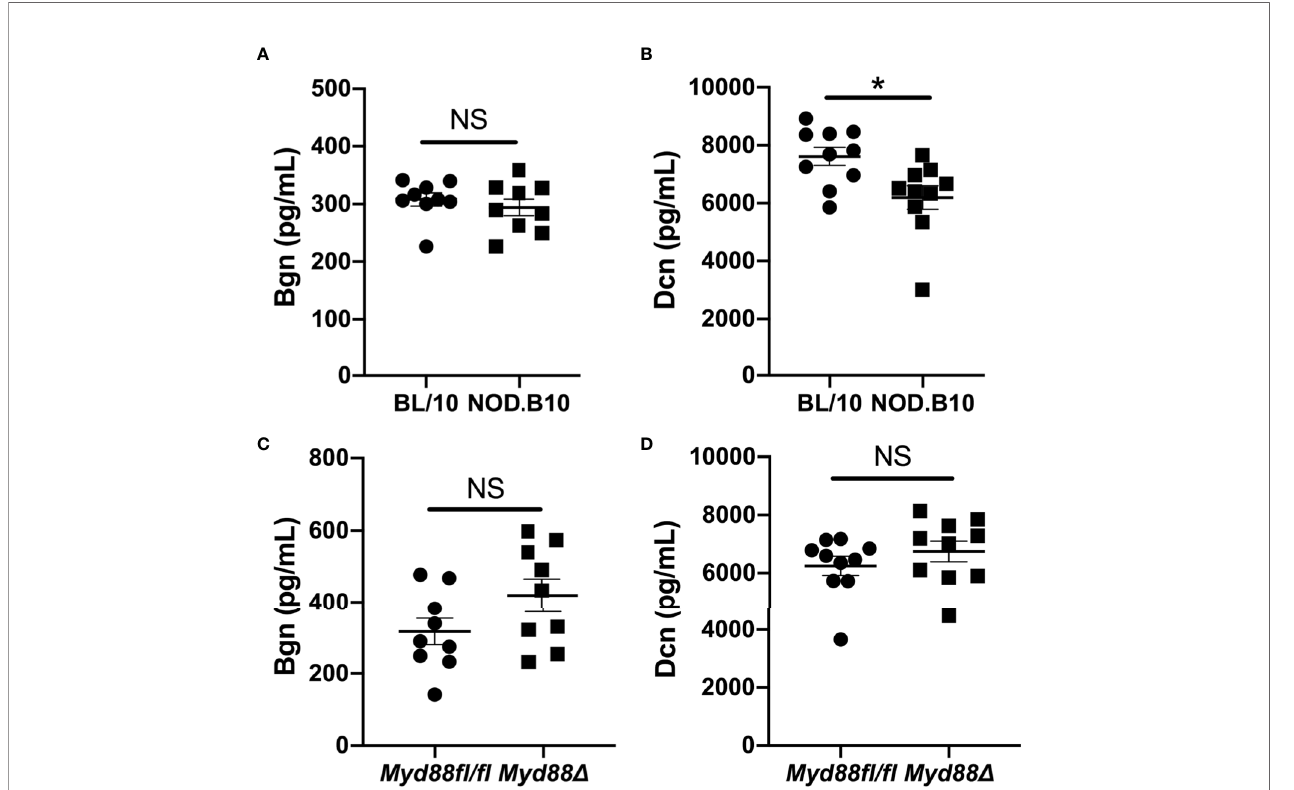
FIGURE 1 | Bgn and Dcn are detected in the sera of pSS mice and controls. Sera were harvested from NOD.B10 and BL/10 mice. ELISAs were performed for (A) Bgn and (B) Dcn. Sera were also collected from NOD.B10 Myd88 fl / fl and NOD.B10 Myd88 D mice and ELISAs were performed for (C) Bgn and (D) Dcn. Sera from 9 or 10 mice from each strain were used for Bgn and Dcn ELISAs, respectively. Horizontal lines represent the mean and SEM, (NS, non-signi fi cant; *p <